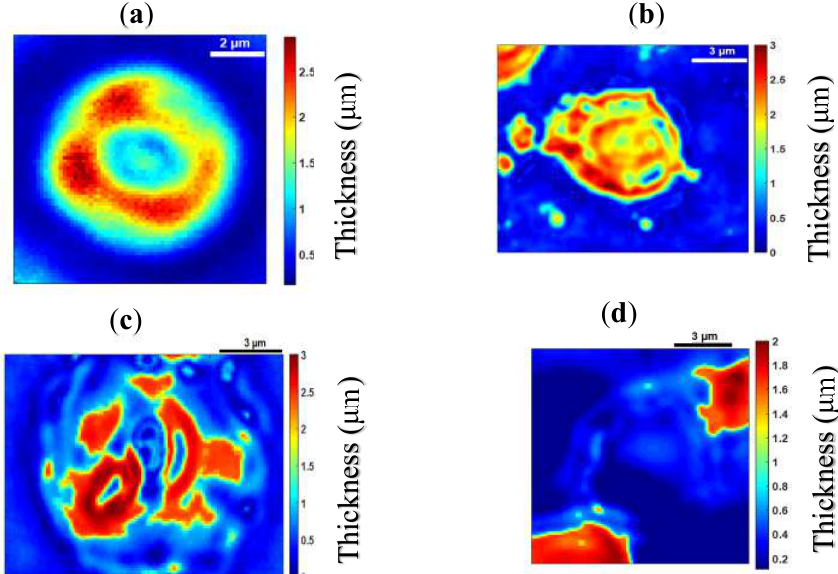
Figure 10. Topography of cell B ( a ), cell C ( b ), cell D ( c ) and cell E ( d ).